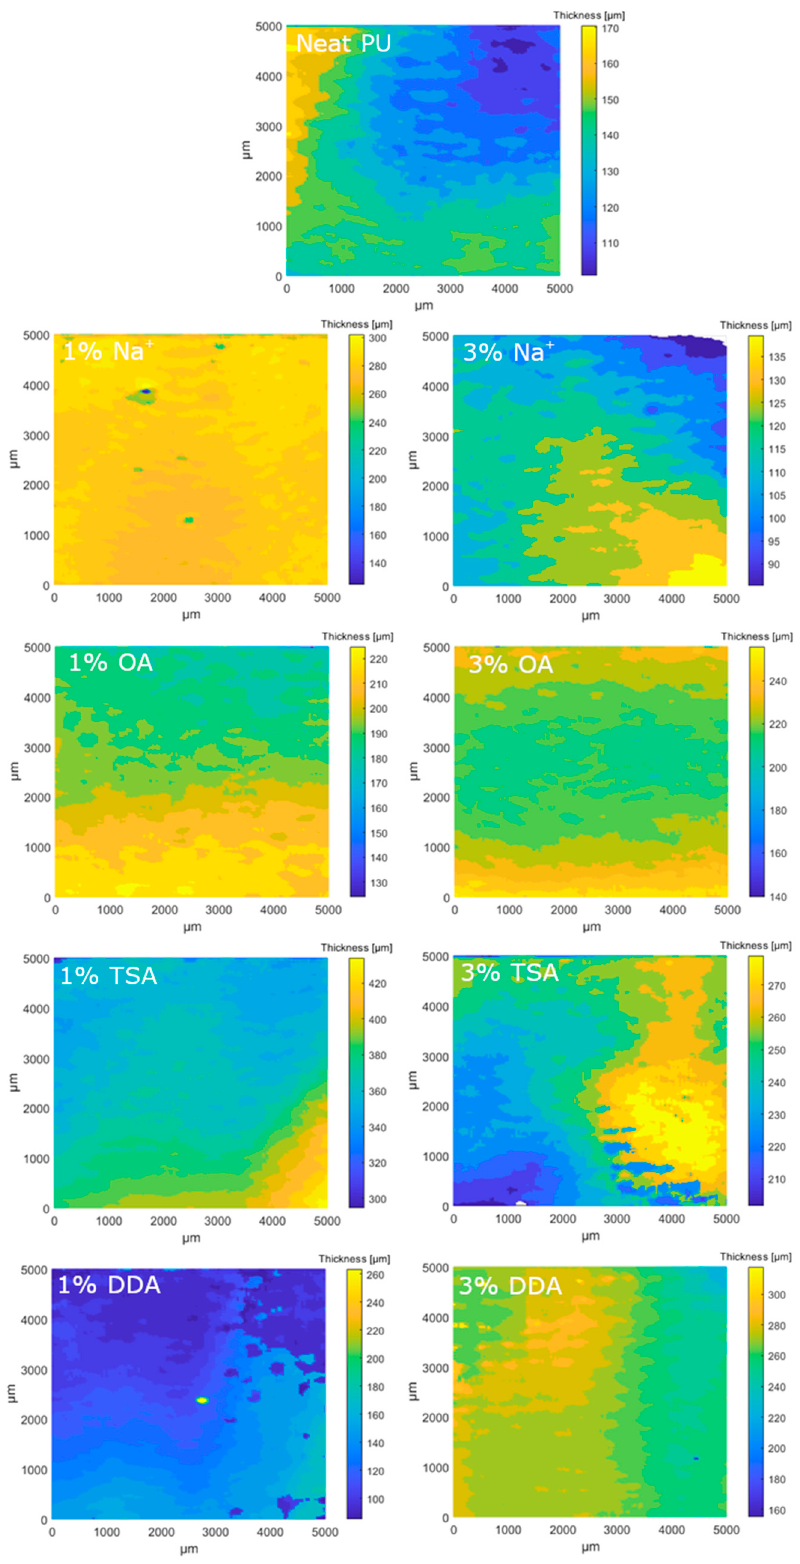
Figure 11. The surface map (according to C-scan plane) of the sample thickness.